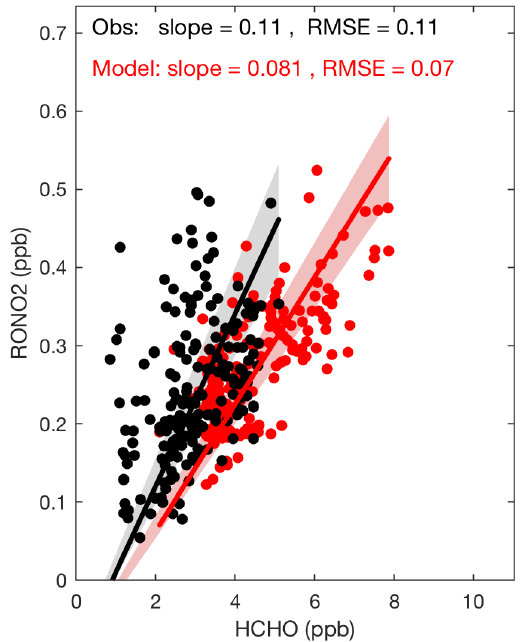
Figure 6. The modeled and observed correlations between O x ( = O 3 + NO 2 ) and organic nitrate concentrations during daytime at SOAS. The lines indicate linear regression (intercept fixed at 0) and confidence intervals. The panel includes slopes of the lines and root mean square errors (RMSE).